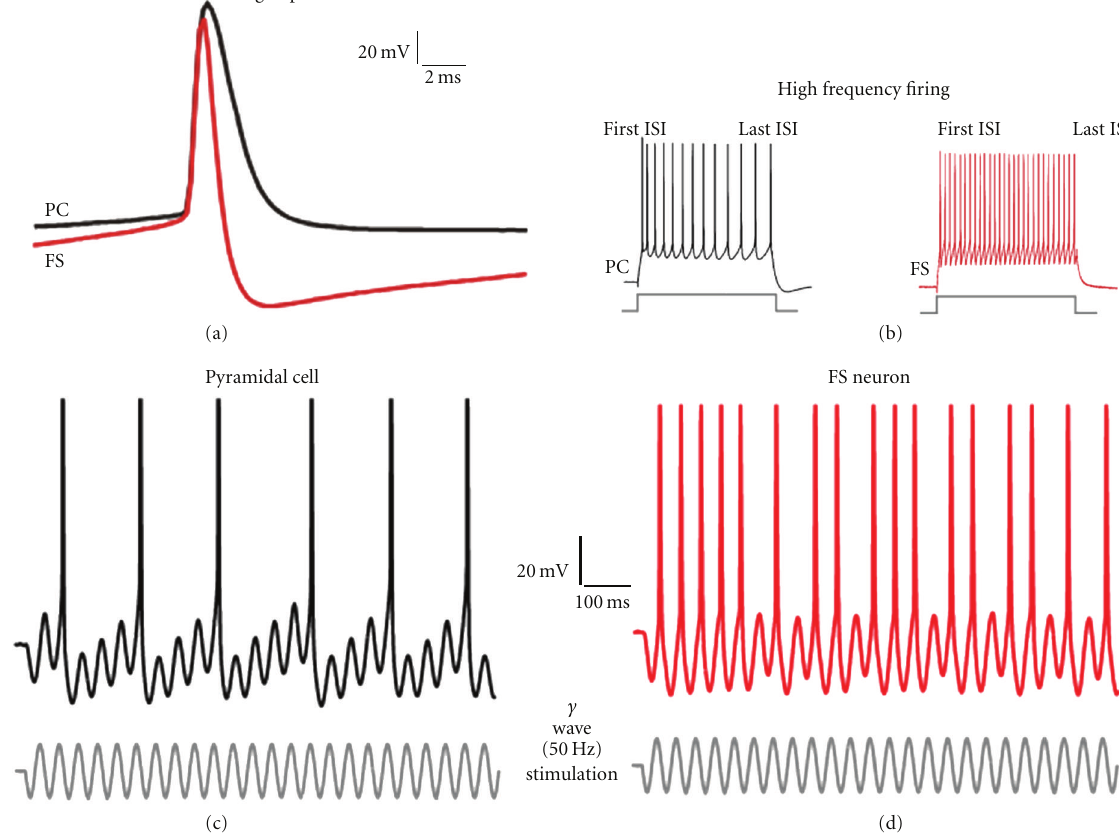
Figure 5: Intrinsic electrical properties of parvalbumin-positive GABA neurons. (a) Single action potentials in fast-spiking PV-positive neurons (FS) have significantly faster duration than pyramidal cell (PC) spikes or spikes in many other GABA neuron subtypes (not shown). (b) In response to sustained depolarizing current injection (500ms rectangular current pulses shown below the traces), PCs produce high- frequency firing with significant spike-frequency adaptation as revealed by comparing the first and last interspike intervals (ISI). In contrast, adaptation of FS cell firing is much less significant or absent. (c) In response to gamma wave stimulation (sinusoidal current pulses shown below the traces), PCs show low capacity to respond with firing during each cycle of the gamma wave stimulus. (d) In response to gamma wave stimulation, FS cells show increased firing capacity, initiating spikes in the majority of gamma wave cycles. This property of the FS neuron membrane may contribute to the activation of FS neurons during gamma oscillations in vivo and is likely due to the resonance or frequency-preference properties (see text) that distinguish FS cells from PCs and also from other GABA neuron